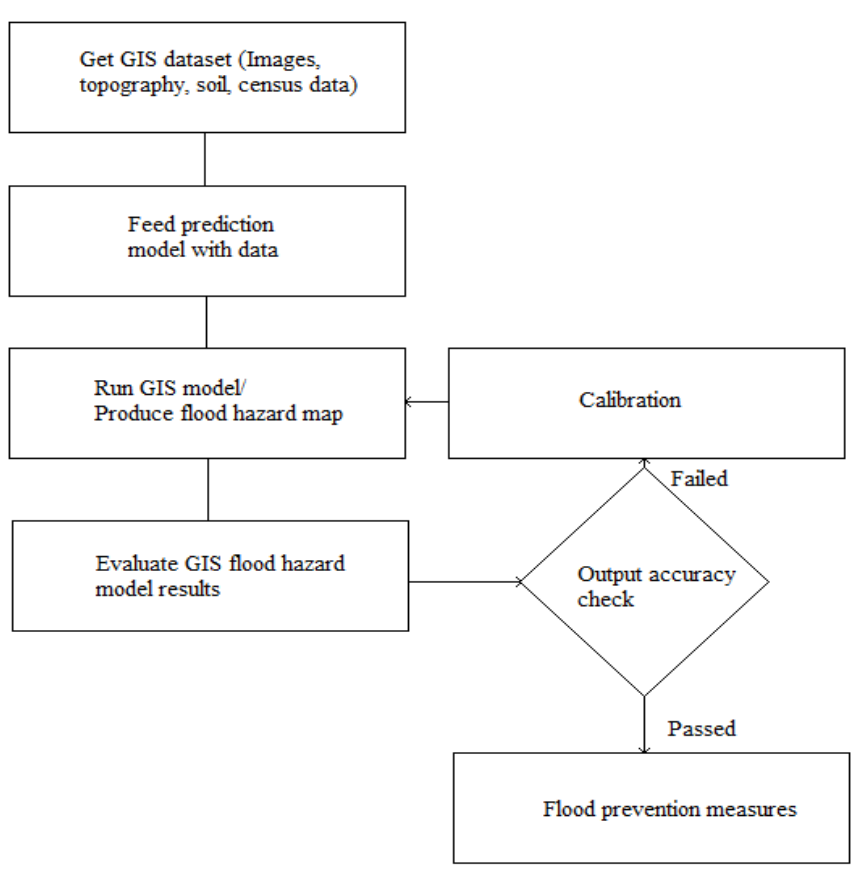
Figure 5. Flowchart of predicting and evaluating flood hazard.